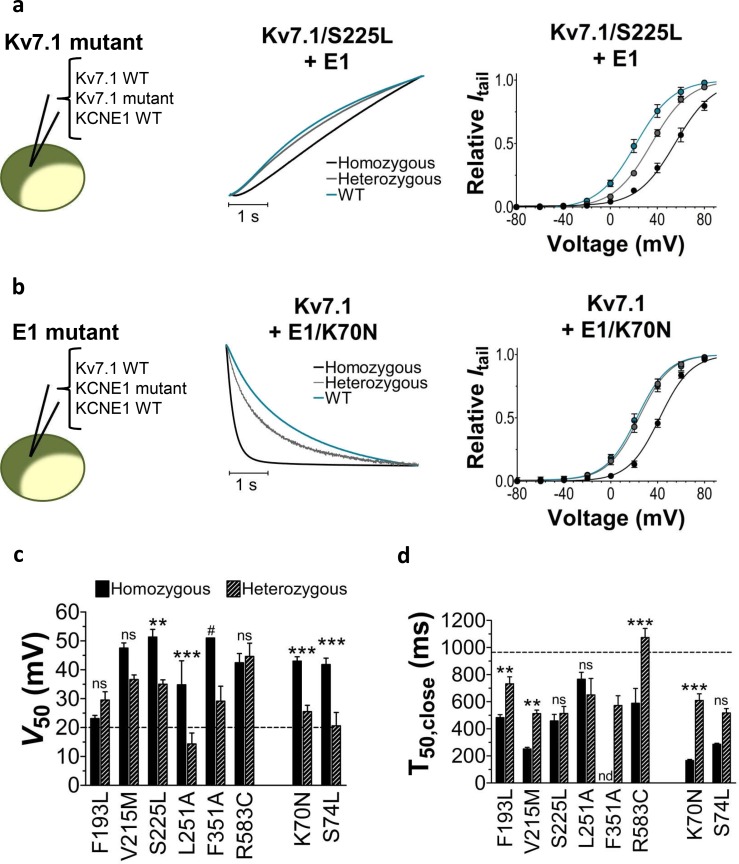
Comparison of homozygous and heterozygous expression of LQTS and LQTS-like mutants.(a–b) Representative example of kinetics (middle panel) and G(V) (right panel) for homozygous expression and heterozygous expression of S225L (a) and K70N (b). Currents in response to steps from –80 mV to +40 mV (a, middle pane) and from +40 mV to –20 mV (b, middle panel). Homozygous expression (black), heterozygous expression (gray), and KV7.1+KCNE1 wild-type (blue). n = 7–13. (c–d) Summary of V50 (c) and T50 for closing (d) for homozygous and heterozygous expression. Data as mean ± SEM. n = 5–13. The statistics represent one-way ANOVA with pair-wise Bonferroni’s Test to compare homozygous and heterozygous expression; **p<0.01; ***p<0.001; ns is p≥0.05. # denotes lowest estimate. Not determined (nd). The statistics was not calculated for F351A. Dashed lines denote corresponding values for wild-type KV7.1+KCNE1.